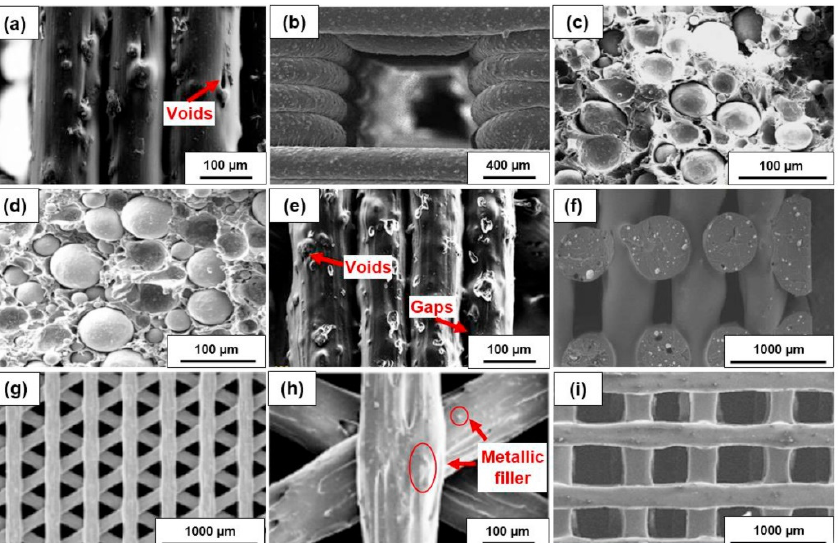
Figure 30. Scanning electron microscope (SEM) images of the structure of different polymer/metal composite scaffolds obtained by FDM: ( a ) PLA/10 vol % 316L stainless steel; ( b ) PLA/15 vol % Ti; ( c ) cross section of the PLA/24 vol % Cu; ( d ) cross section of PLA/30 vol % bronze; ( e ) PLA/10 vol % Fe, ( f ) PLA/7 vol % Mg, ( g , h ) PCL/6.8 vol % Mg; and ( i ) PCL/6.1 vol % Mg [180].